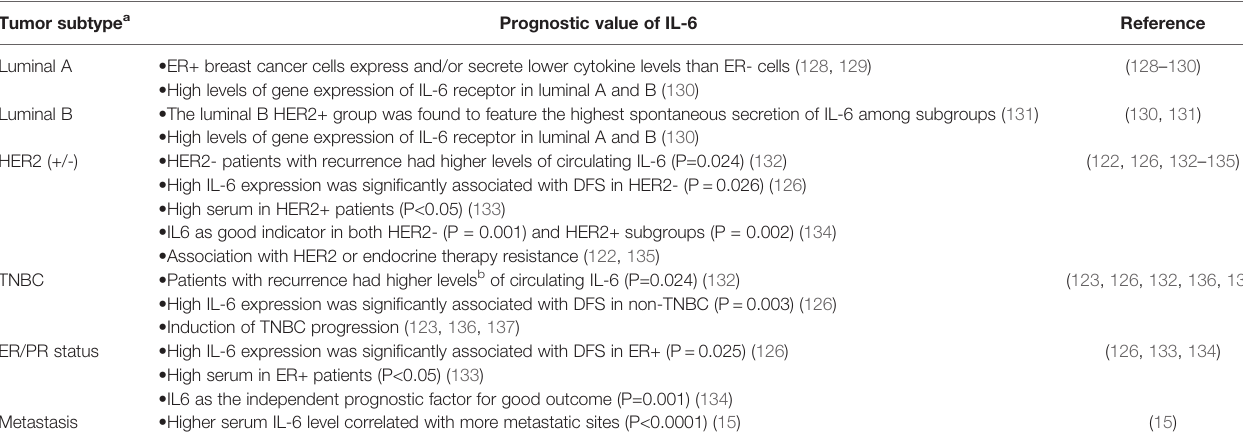
TABLE 1 | Prognositc value of IL-6 in different types of breast